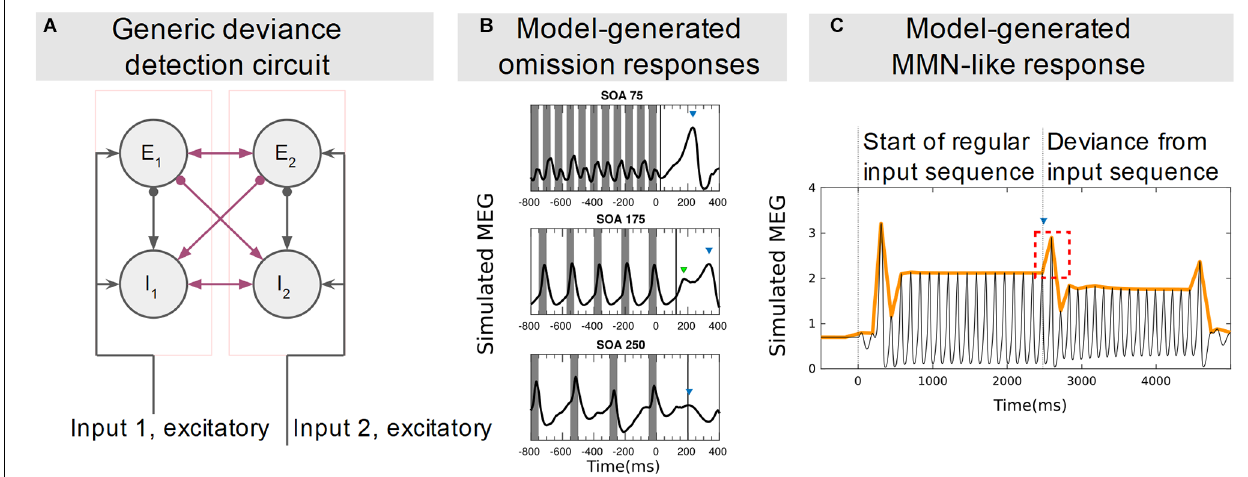
FIGURE 4 | Computational model of deviance detection nodes and simulated MEG signals. (A) Architecture of generic deviance detection circuit with two reciprocally connected stimulus-selective nodes (pink squares) that can function as deviance detectors for each other’s activation state. The synaptic weights of the inter-node connections (magenta) are the free parameters of the model. Circles indicate neural populations, excitatory (E 1,2 ) and inhibitory (I 1,2 ), and lines indicate their connectivity. Arrows and filled circles indicate excitatory and inhibitory synapses, respectively. (B) Simulated magnetoencephalography (MEG) signals of a network composed of multiple such nodes include responses (arrows) to the omission (at time 0) of a stimulus from a regular input sequence. The responses, and their dependence on stimulus onset asynchrony, closely resemble those observed experimentally in recordings from human listeners. Adapted from Andreou et al. (2015). (C) Simulated MEG signals from a network composed of the same nodes shown in (A) . As the input is switched from a regular to a random sequence, an MMN-like increase in response amplitude is observed in response to the first deviant of the sequence (arrow and dashed square). The time series closely resembles those observed in recordings from human listeners (Barascud et al., 2016) with the same stimulation protocol. Adapted from Chien et al.